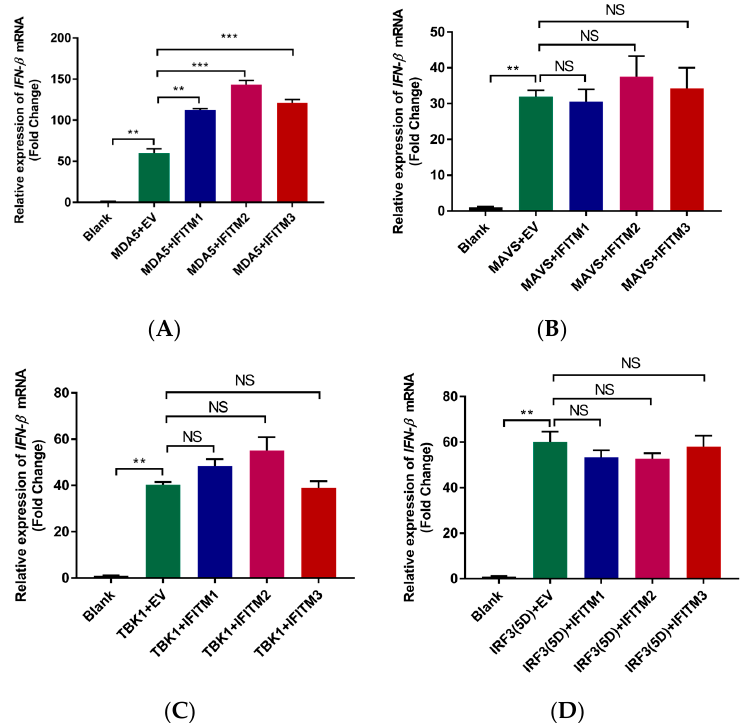
Figure 6. HEK293 cells were cotransfected with empty vector (0.5 µg) or Myc − IFITM1/ − IFITM2/ − IFITM3 (0.5 µg) plasmids and the indicated plasmids expressing MDA5 (0.2 µg) ( A ), MAVS (0.2 µg) ( B ), TBK1(0.2 µg) ( C ), or IRF3(5D) (0.2 µg) ( D ) for 24 h. Then, cells were collected for total RNA extraction. IFN −β mRNA expression level was measured via RT-qPCR. Data were expressed as mean ± SDs from three independent experiments and were measured in technical duplicate. Comparisons between groups were performed using the Student’s t − test. *** p < 0.001, ** p < 0.01.